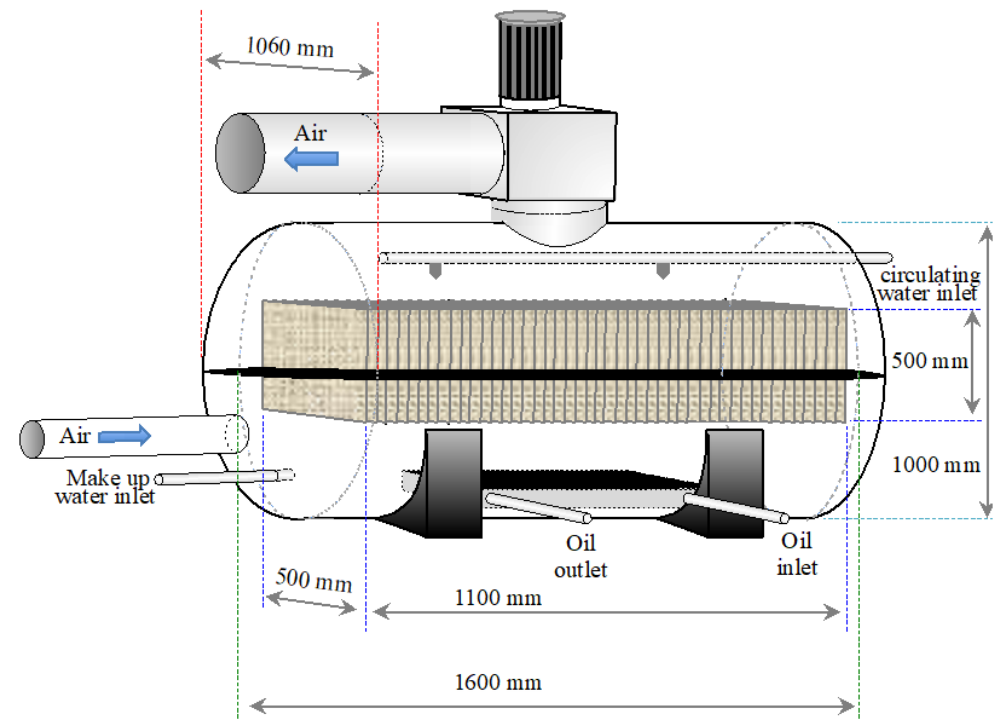
Figure 5. Schematic diagram of the humidifier. Processes 2018 , 6 , x FOR PEER REVIEW